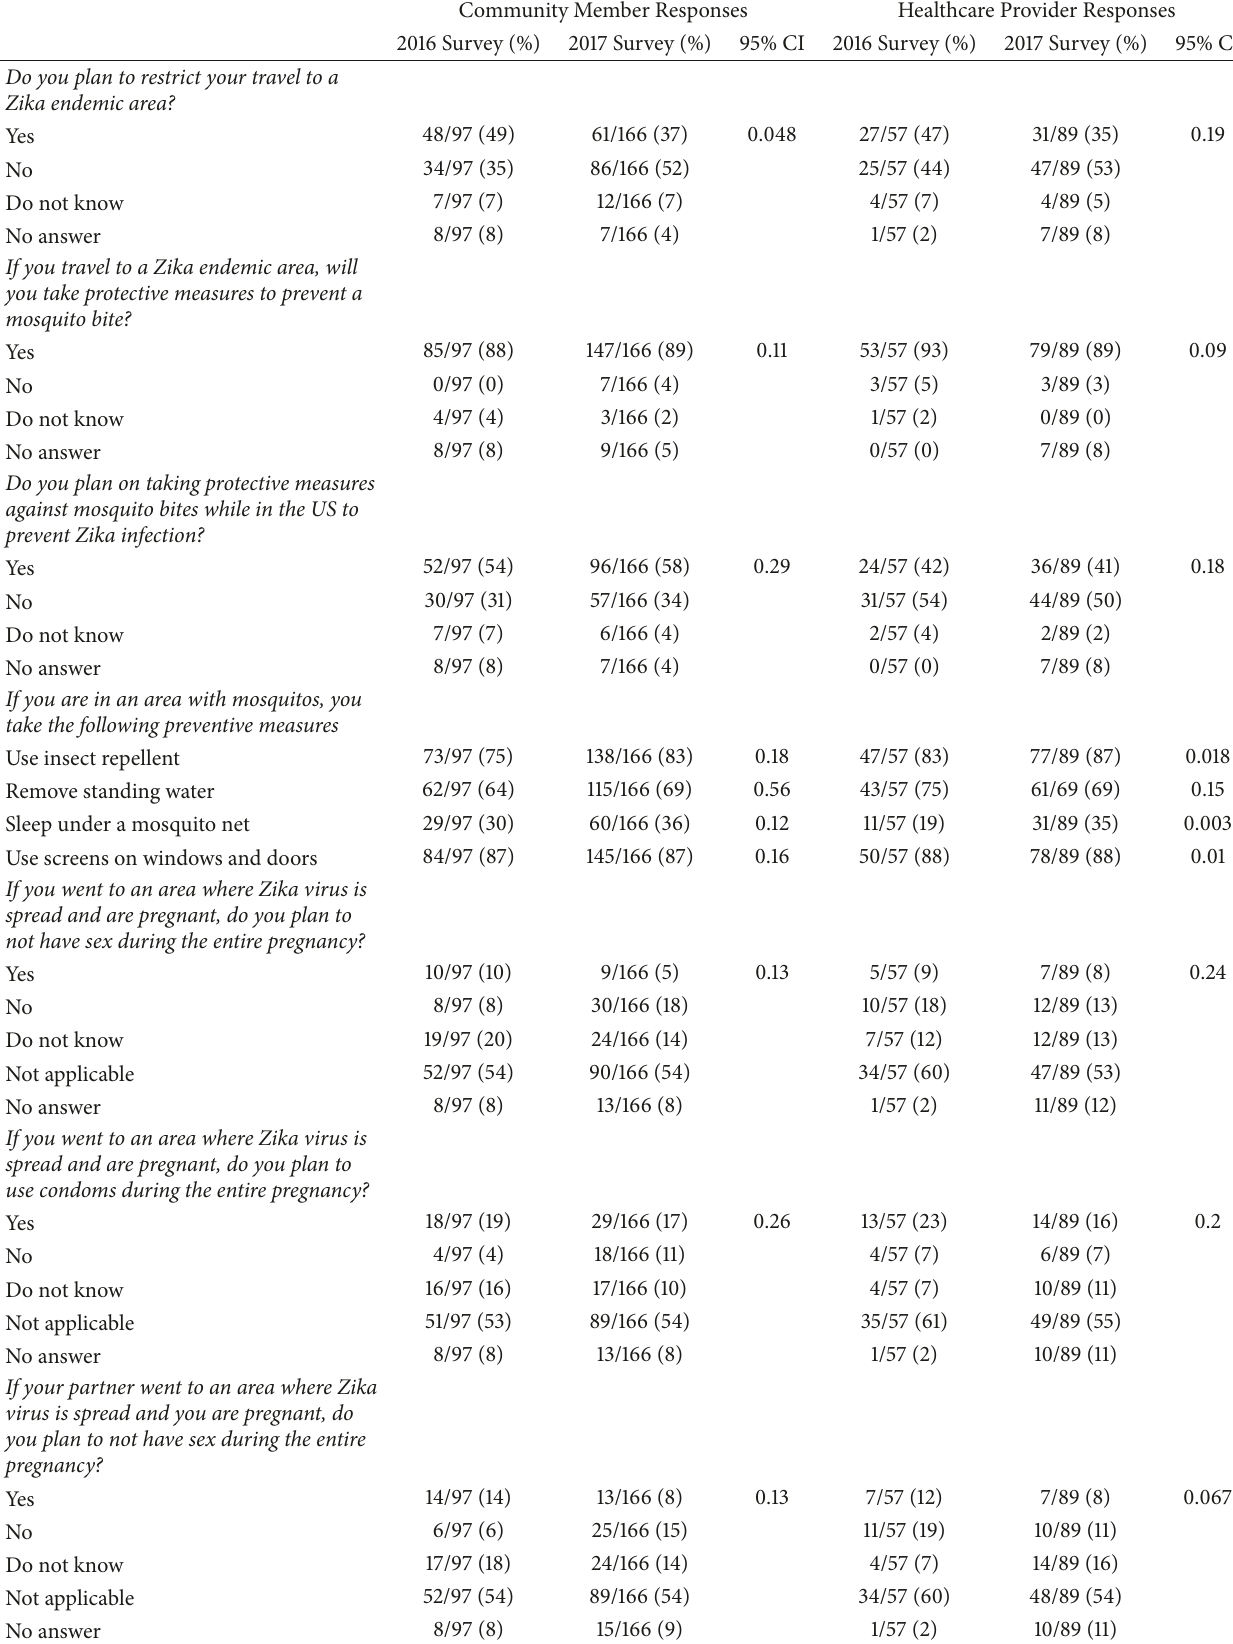
Table 4: Responses to “practice” questions regarding Zika virus disease and